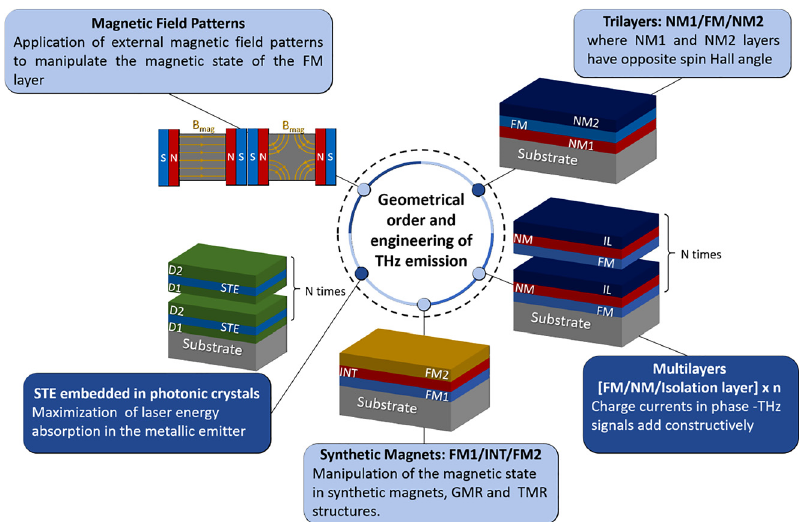
Figure 8: Graphical representation of geometrical stacking order that can influence the intensity, bandwidth and the polarization state of the emitted THz signals. FM denotes the ferromagnetic layer, NM the nonmagnetic layer, IL the isolation layer, STE is the spintronic emitter, D1,2 the dielectric layers and INT the interlayer in synthetic magnetic